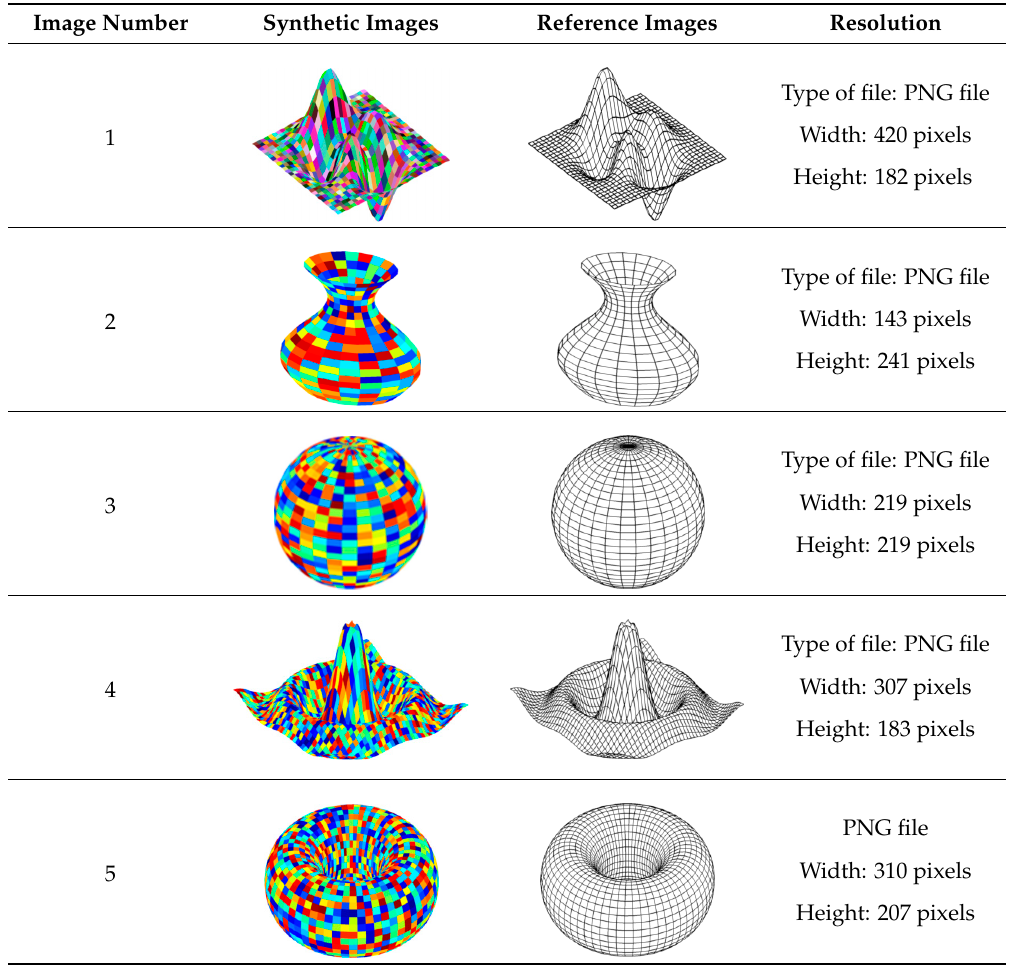
Table 2. Synthetic color image database.